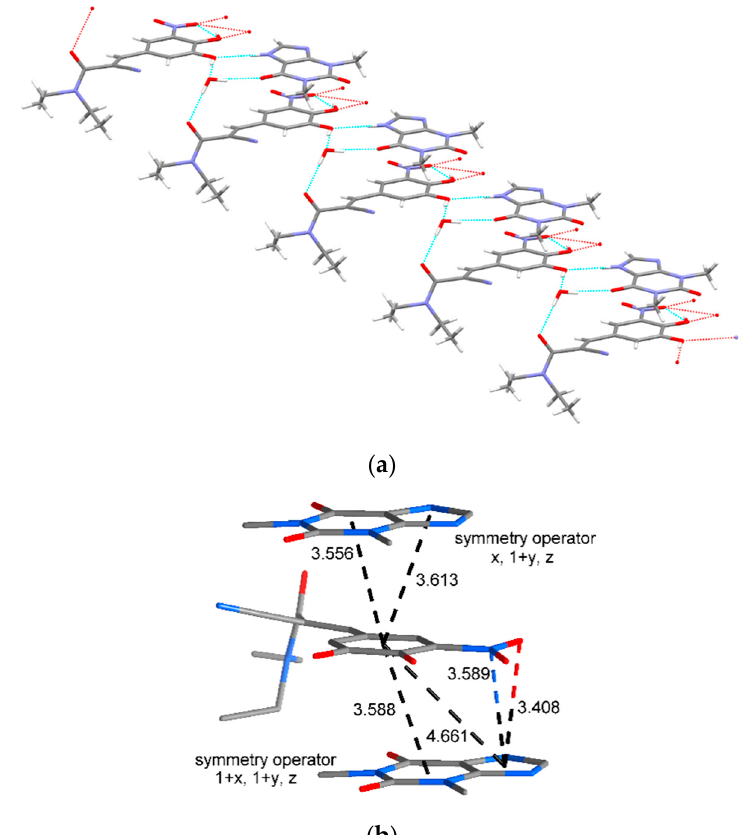
Figure 1. ( a ) Packing arrangement of entacapone, theophylline, and water molecules, showing the hydrogen bonding interactions as blue and red dashed lines. ( b ) Packing arrangement of entacapone and theophylline in the cocrystal with π - π interactions (in Å) as dashed lines between and to the ring centroids (hydrogen atoms omitted for clarity).